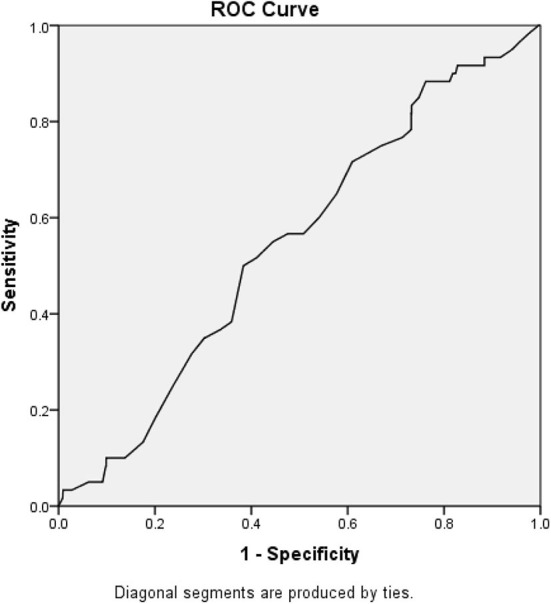
Receiver operating curve and area under the curve. The optimal cutoff that differentiates between survivors and non-survivors was found to be 1.33, and the area under the curve for that value was 0.545 (95% CI 0.477–0.614).